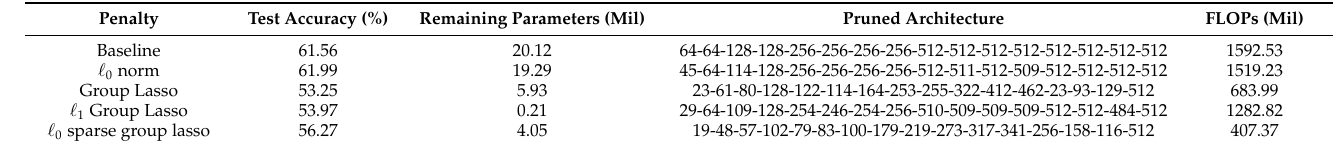
Table A6. Alation studies on VGG19.